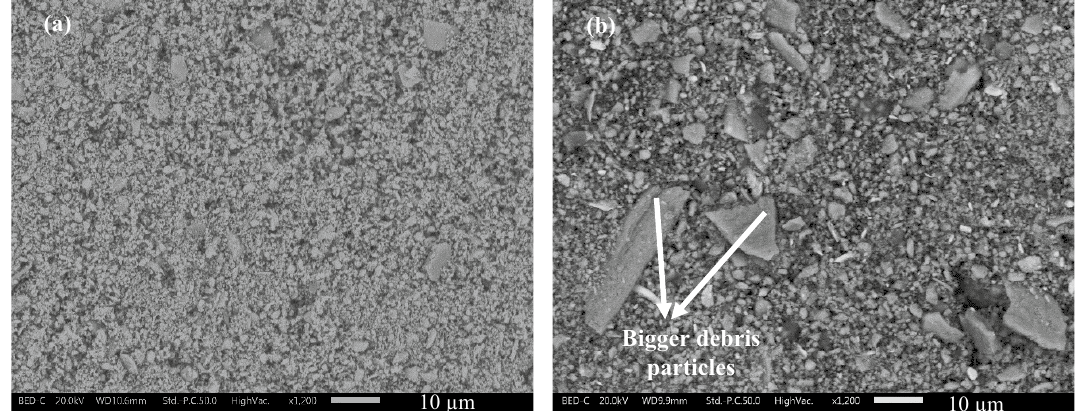
Figure 7. Wear debris morphology ( a ) CFM; ( b ) CFM with 38wt% of FS.